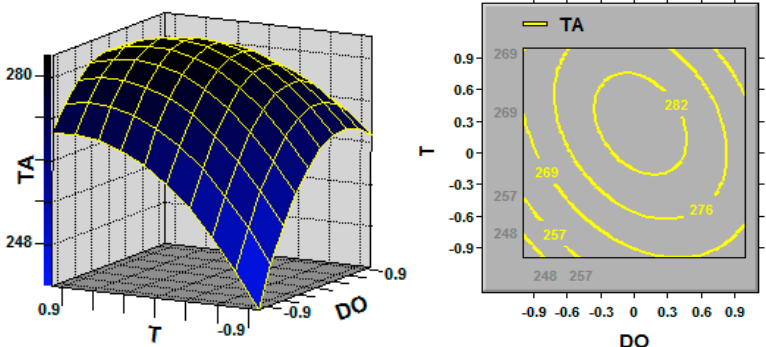
Figure 3. Response surface curve ( left ) and contour plot ( right ) for triterpene acid (TA; mg/L) production illustrating the interaction between the dissolved oxygen (DO) and temperature (T) at the coded levels. Fixed level: initial pH = 0.